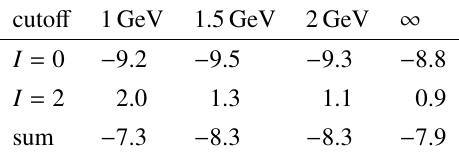
Table 2. S -wave rescattering corrections to a π -box 10 − 11 , for both isospin components and in